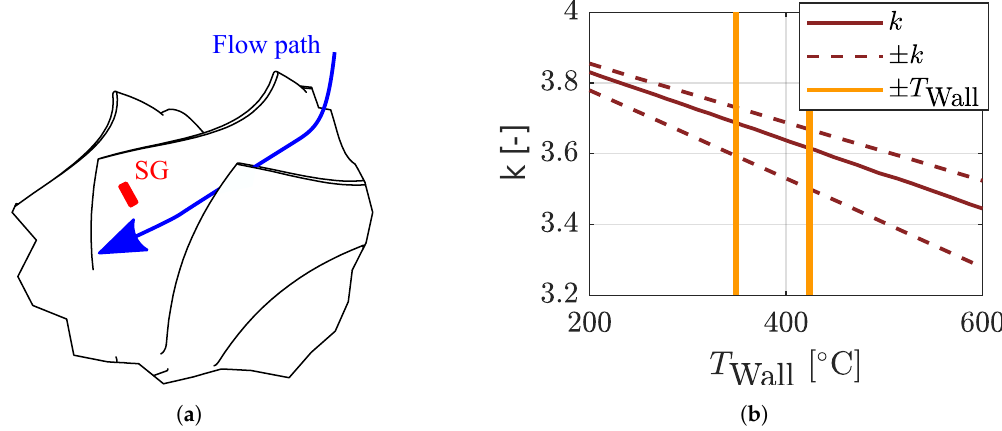
Figure 1. Positioning and temperature sensitivity drift of high-temperature strain gauges. ( a ) Relative blade position of a high-temperature strain gauge (SG) on the suction side of one blade; ( b ) Nominal sensitivity and sensitivity uncertainty (specified by the manufacturer) over